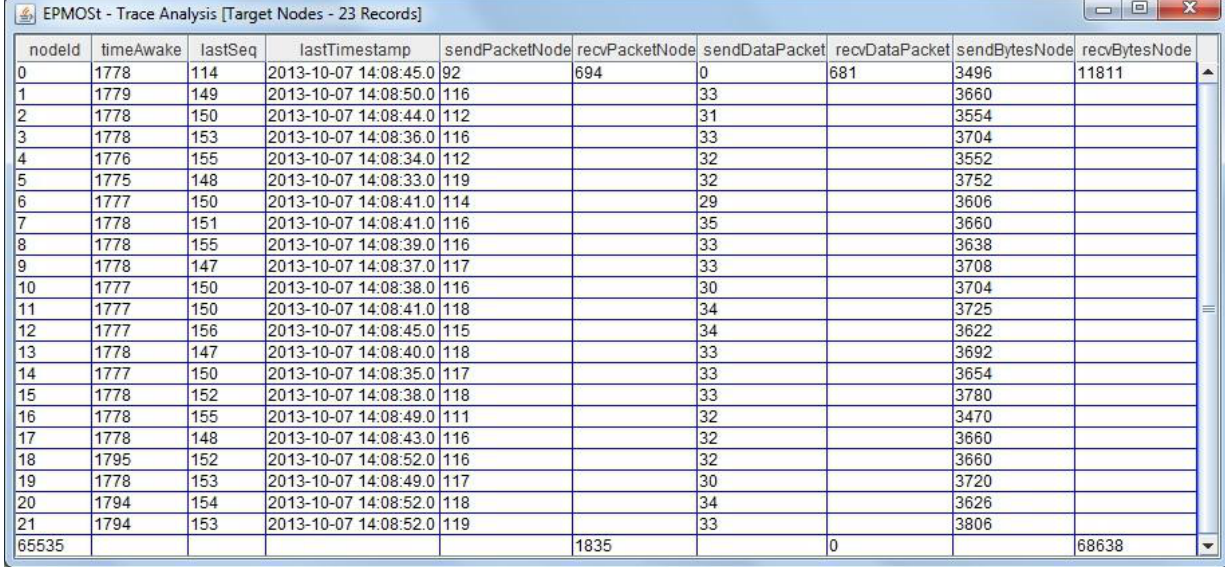
Figure 7. Example of information about the nodes of the target